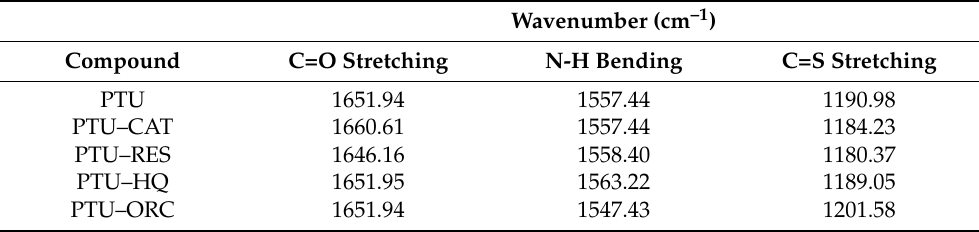
Figure 14. QTAIM/NCIPlot analysis of intermolecular bond, ring, and cage CPs (red, yellow and cage spheres, respectively), and bond paths and RDG isosurfaces of the π -assemblies of PTU–HQ ( a ), PTU–CAT ( b ), and PTU–RES ( c ) cocrystals. Table 2. Characteristic FT-IR bands of PTU and their attribution in PTU alone and the obta- ined cocrystals.